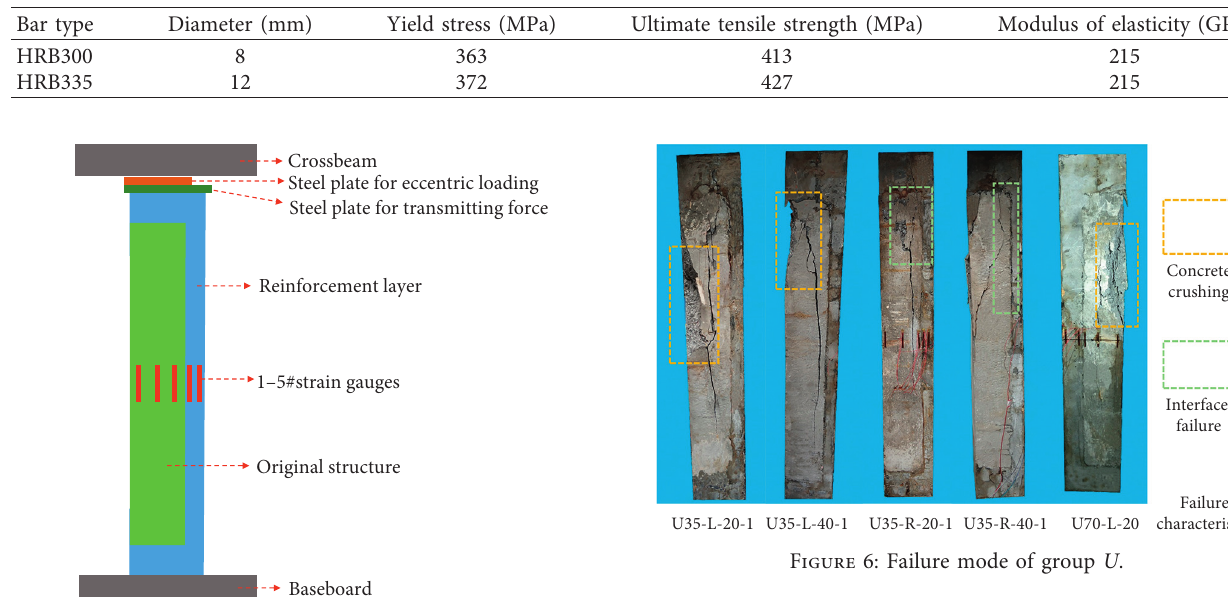
Table 5: Steel reinforcement results.